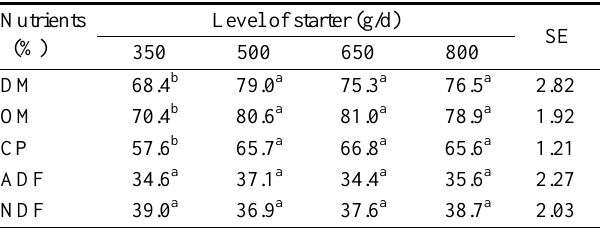
Table 4. Effects of levels of starter on nutrients digestibility